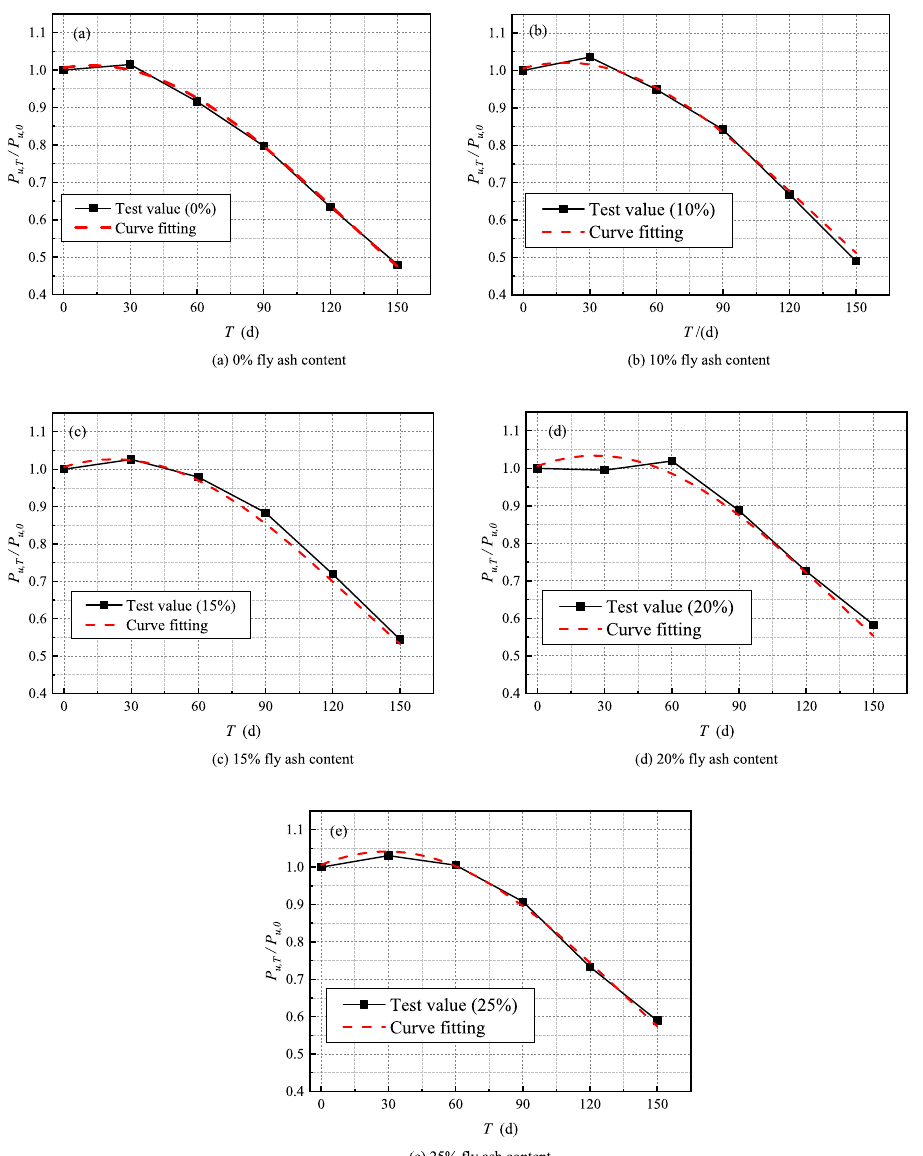
Figure 12. Time-varying curve of stripping bearing capacity for different fly ash